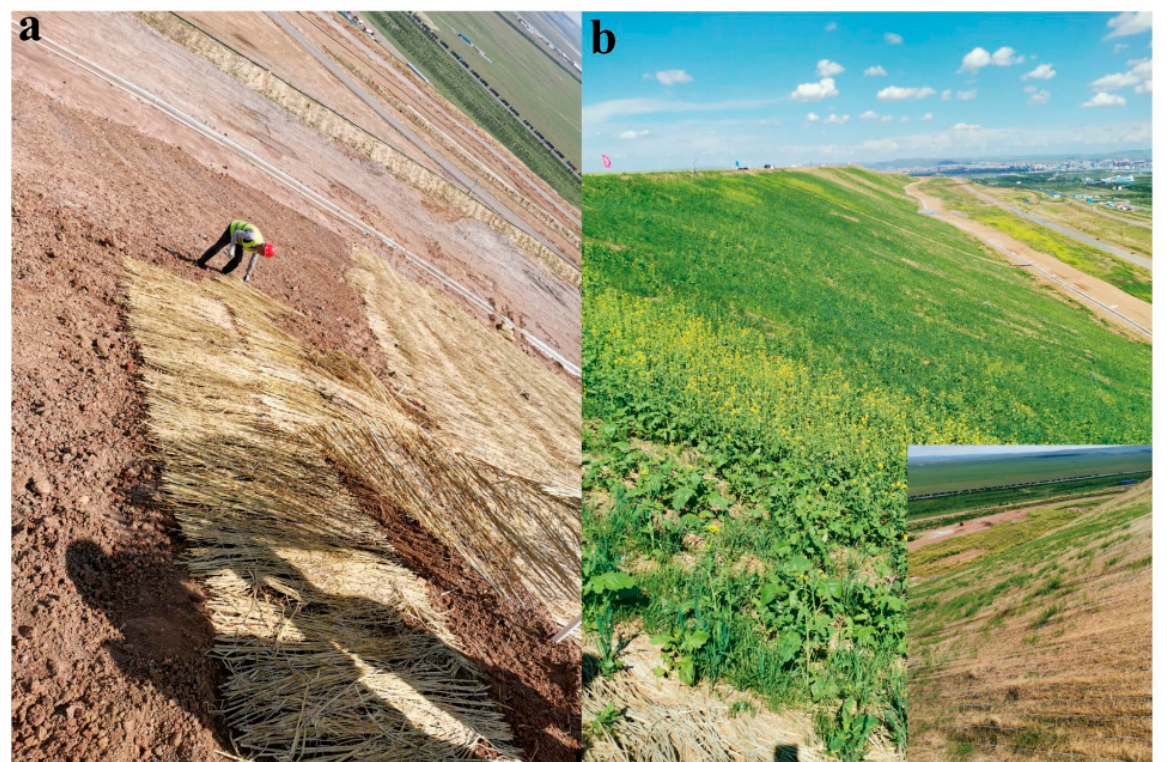
Figure 5. Application of seeded spoil dumps covered with fibrous straw mulch in revegetation. ( a ) Covering of the sowed with straw thatch. ( b ) Comparison of refuse dumps before and after restora-